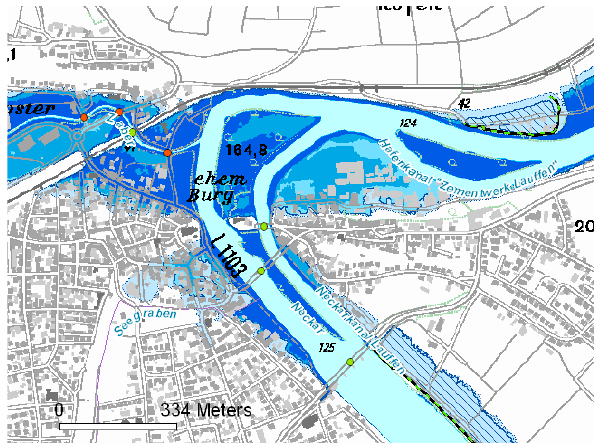
Fig. 2. Flood hazard map depicting expected inundation extent for four different flood scenarios. Graphic from the online map service available from the Ministry of the Environment (http: //rips-dienste.lubw.baden-wuerttemberg.de/rips/hwgk internet/